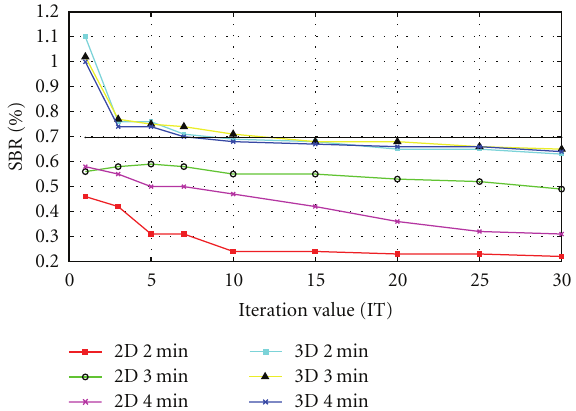
Figure 18: Scanner variables e ff ects on the segmented image.